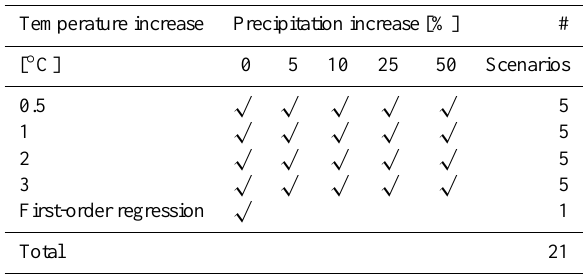
Table 4. Description of climate scenarios